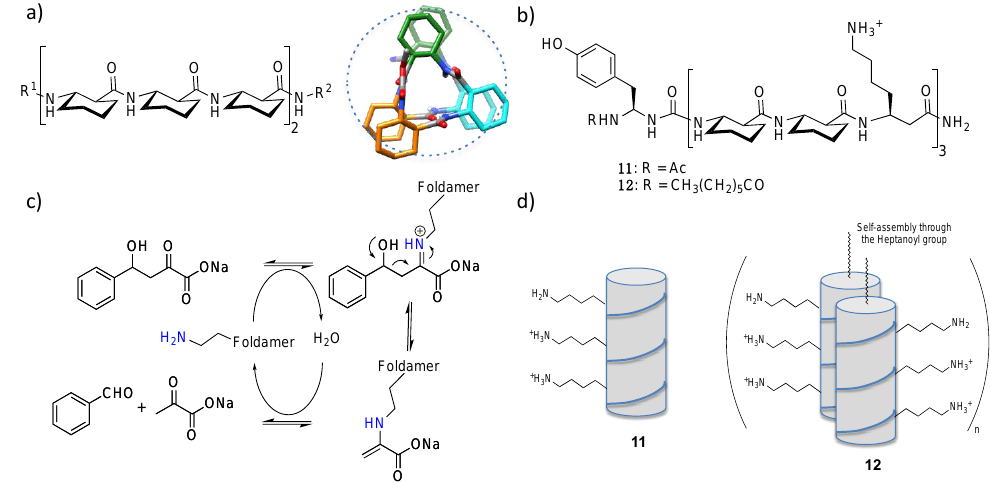
Figure 2. ( a ) Axis view of the helix structure of trans-2-aminocyclohexanecarboxylic acid (ACHC)-containing oligomers (CCDC: 1247870).[63] ( b ) Sequences of β -peptides 11 – 12 : ( β 3 -hLys) residues in an i , i + 3, i + 6 array led to an alignment of the amine-containing side chains. ( c ) Retroaldol reaction of sodium 4-phenyl-4-hydroxy-2-oxobutyrate catalyzed by the β -peptides 11 and 12 . ( d ) Cartoon showing the 3D-organization of β-peptides 11 and 12 .